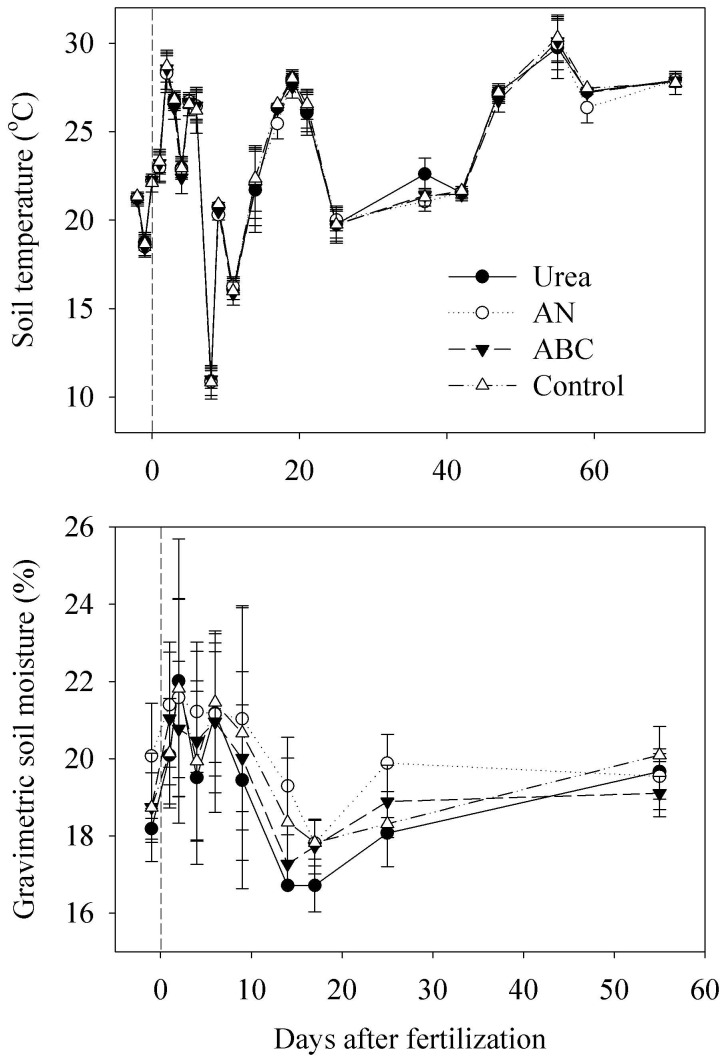
Variation of soil temperature and soil moisture in different treatment mesocosms during the sampling period.Each value is the mean of three replicates, and error bars represent standard errors. Vertical dash line indicates the day when fertilizers were applied.